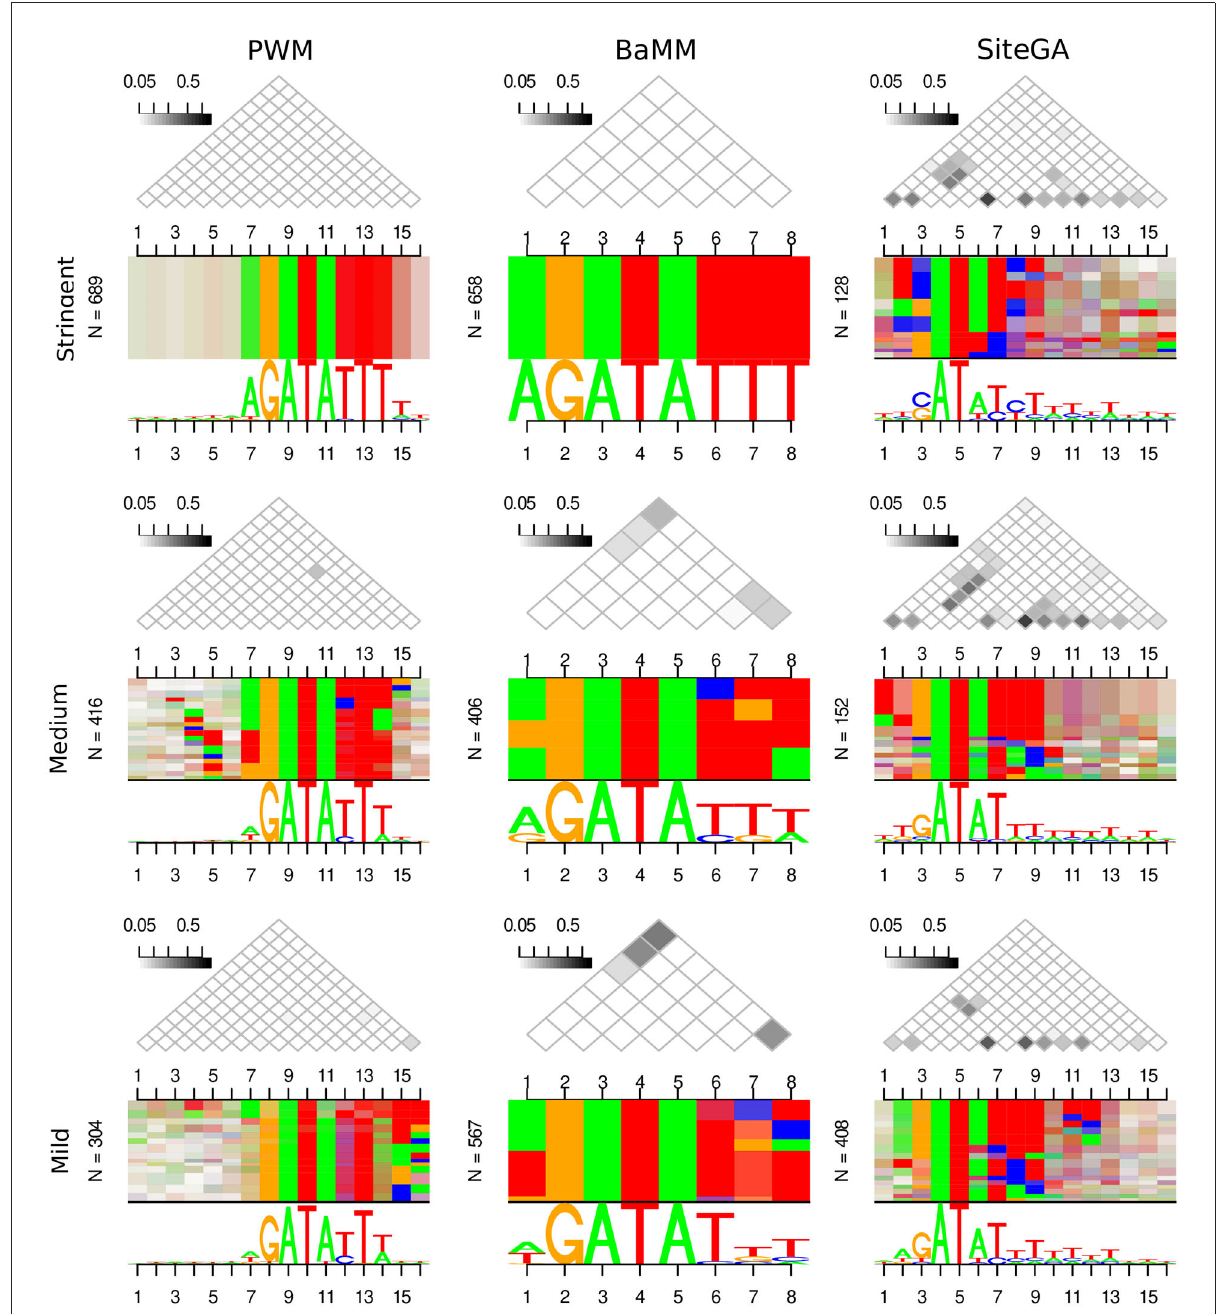
FIGURE3 Traditional and alternative sequence logos represent the alignments of sites predicted by PWM, BaMM, and SiteGA recognition models for CCA1 TF. Three columns show three models. Three rows show the growth of the recognition score: the bottom, middle, and top rows depict the mild, medium, and stringent ranges of recognition scores (2.5E-4 < ERR 6 5E-4, 1E-4 < ERR 6 2.5E-4, and ERR 6 1E-4, respectively, see Section 2). In each of the 3 × 3 cells, the traditional sequence logo is located under the alternative sequence logo (DepLogo, Grau et al., 2019). Above each alternative logo, the triangle matrix shows the mutual information as a measure of the position interdependency. The dependencies are visualized as horizontal boxes showing pairs of interacting nucleotides; from the left side of each logo, the total number of BSs (N) is designated.